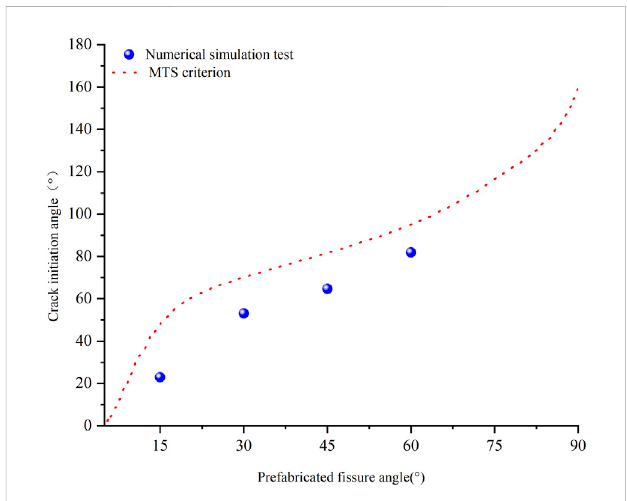
FIGURE 9 Comparison of the experimental results of starting cracking angle with the predicted results of MTS